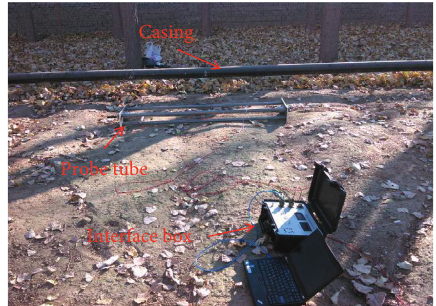
Figure 7: Diagram of simulated experimental